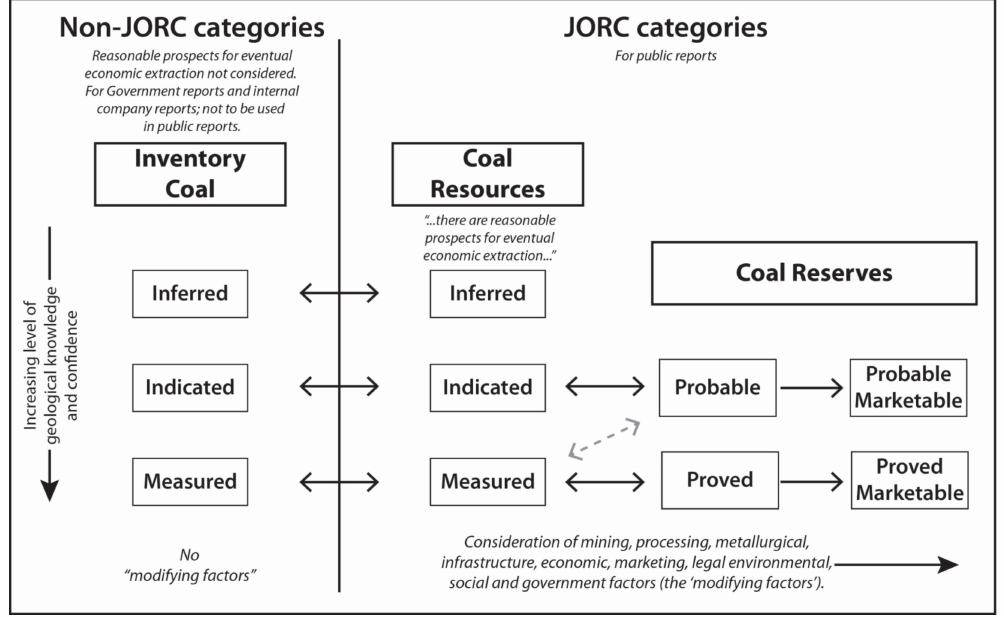
Figure 1. The relationship between Inventory Coal, Coal Resource and Coal Reserves (modified from the Guidelines Review Committee